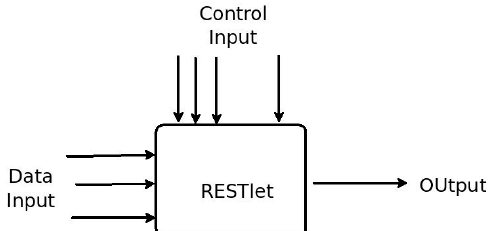
Figure 7. RESTlet Block Diagram.